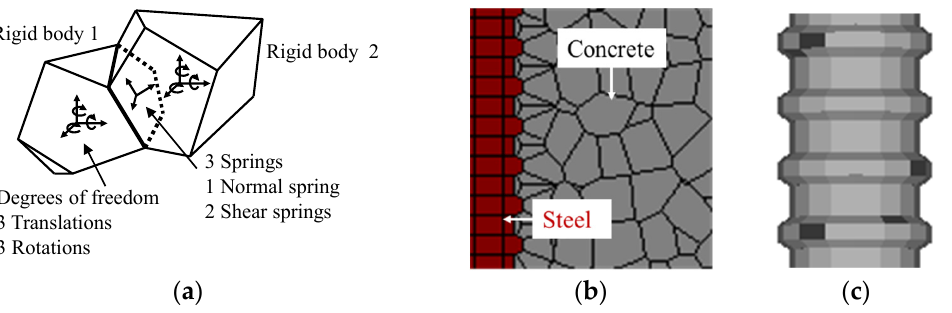
Figure 2. Discretization of the reinforced concrete model in 3D RBSM Reprinted with permission from [13] 2021, Elsevier. ( a ) Polyhedral rigid bodies interconnected by springs; ( b ) cross-section of steel and concrete elements; and ( c ) 3D rebar model.